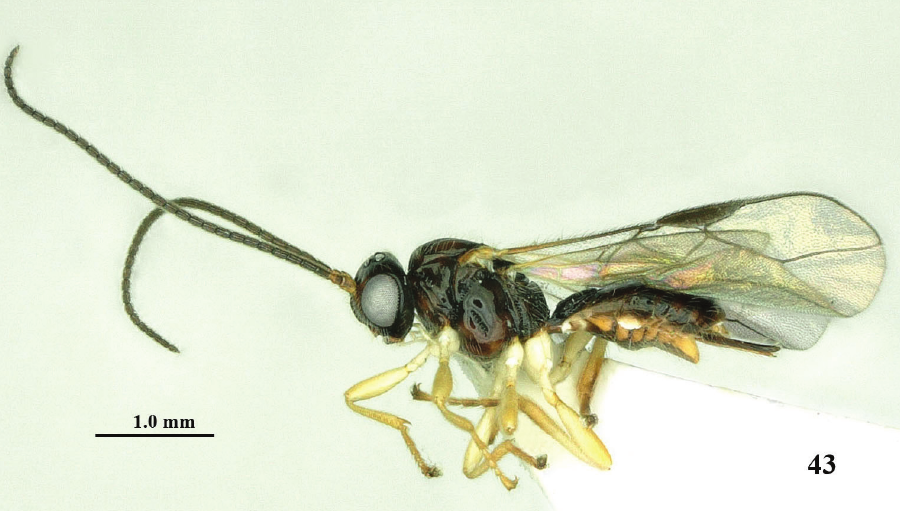
Figure 43. Rhogadopsis moniliata sp. n., female, holotype, habitus